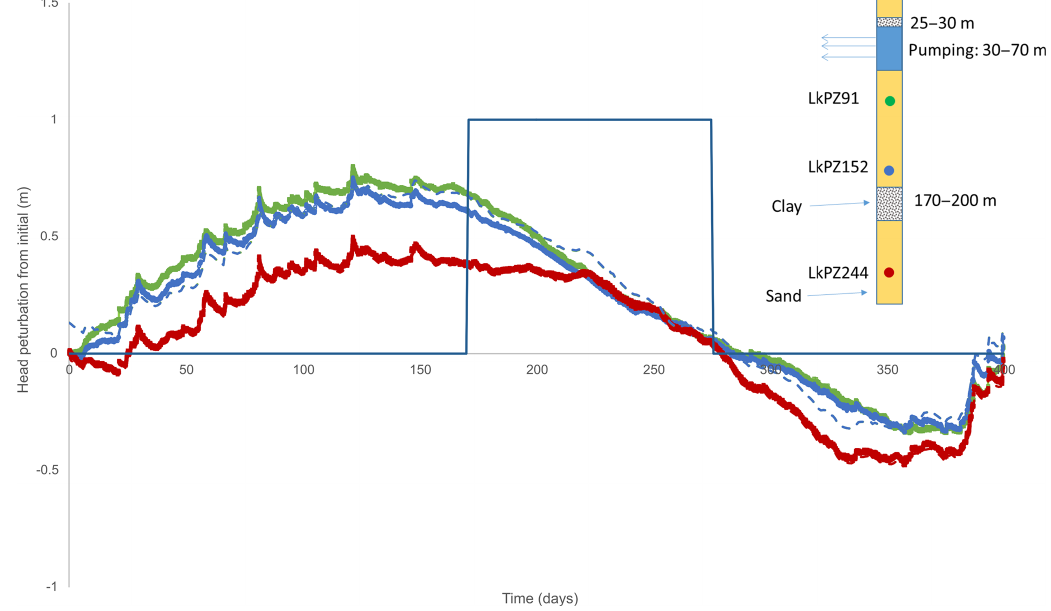
Figure 7. Laksmipur: comparison of observed heads (solid lines) and simulated heads (dashed lines) starting 31 May 2013, for the “WT” upper boundary condition ( S y = 0 . 8), and for LkPZ91 (green), LkPZ152 (blue), and LkPZ244 (red). The x axis is time in days. The surface loading is set equal to the observed head in LkPZ244, and the surface head is set to the observed head in LkPZ244 divided by S y . The pumping rate is 0.04ma − 1 for the period shown (1 for “on”, 0 for